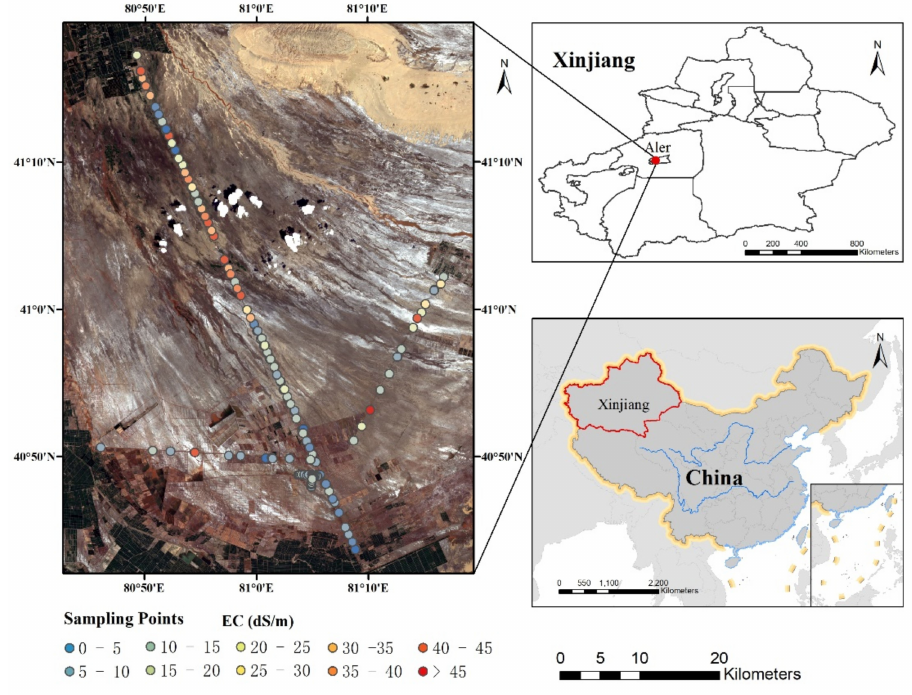
Figure 1. Geographical extent of the study area and the locations of sampling points. A total of 151 points were measured for soil electrical conductivity (EC) in two